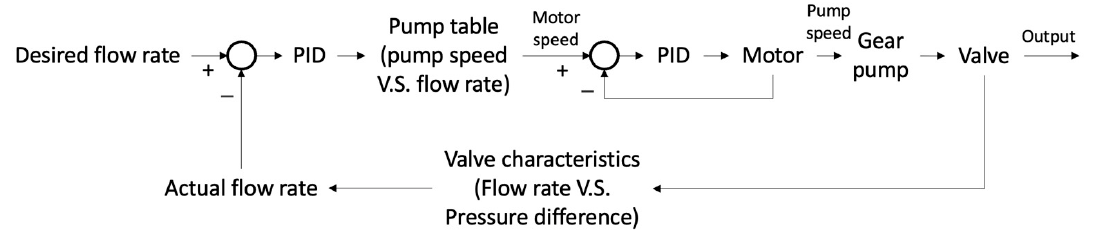
Figure 4. Electric fuel system control loop [25].